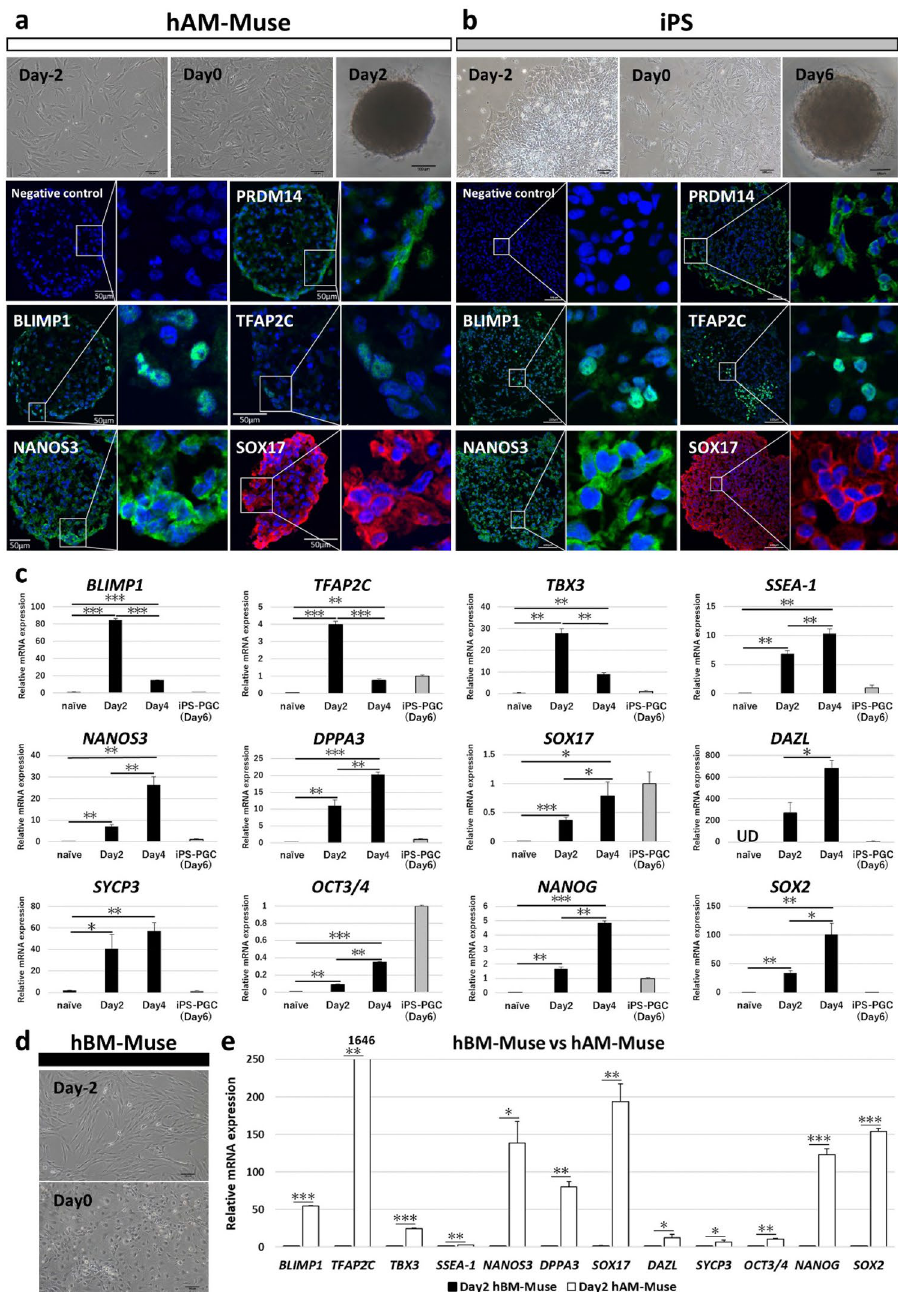
Figure 4. In vitro differentiation of hAM-Muse cells into germ cell-lineage marker (+) cells. ( a , b ) iMeLC and hPGCLC induction in hAM-Muse ( a ) and iPS ( b ) cells. Aggregations of hAM-Muse and iPS cells were subjected to immunocytochemistry for germ cell-lineage markers (PRDM14, BLIMP1, TFAP2C, NANOS3, and SOX17). (Immunocytochemistry in hAM-Muse cells, bars = 50 µm; others, bars = 100 µm). ( c ) Expression of germ cell- and pluripotency-related genes in naïve hAM-Muse cells, day 2 and day 4 after hPGCLC induction and iPS cells at day 6 after hPGCLC induction (normalized by ACTB ). Values of induced iPS cells were set as 1. * p < 0.05; ** p < 0.01; *** p < 0.001; UD = under detected. ( d ) hBM-Muse cells after iMeLC induction. (bars = 100 µm). ( e ) Expression of germ cell- and pluripotency-related genes compared between hBM- with hAM-Muse cells at